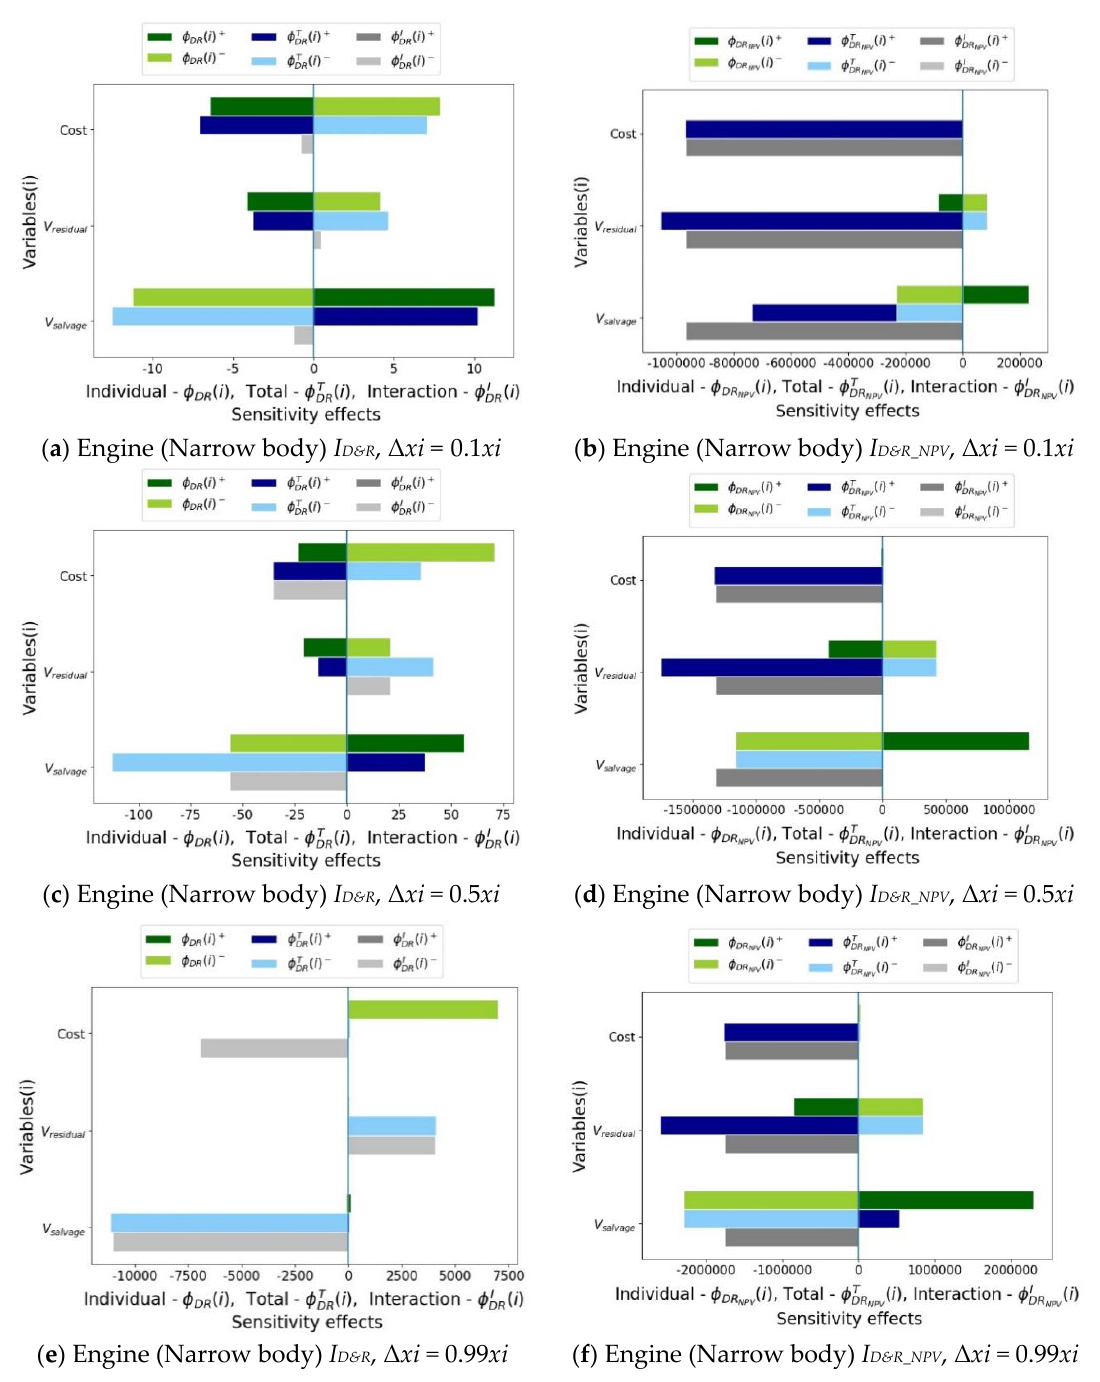
Figure 4. General sensitivity diagram–Engine (Narrow body).